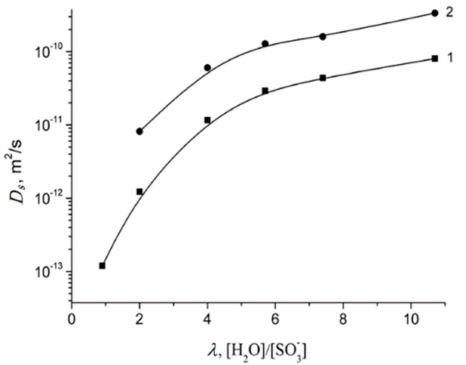
Figure 34. Self-diffusion coefficients of Li + ions (curve 1) and water molecules (curve 2) dependences on water content λ in Nafion 117 membrane Li + ionic form, where λ is water amount per sulfonate group. Reprinted with permission from [109]. Copyright 2021